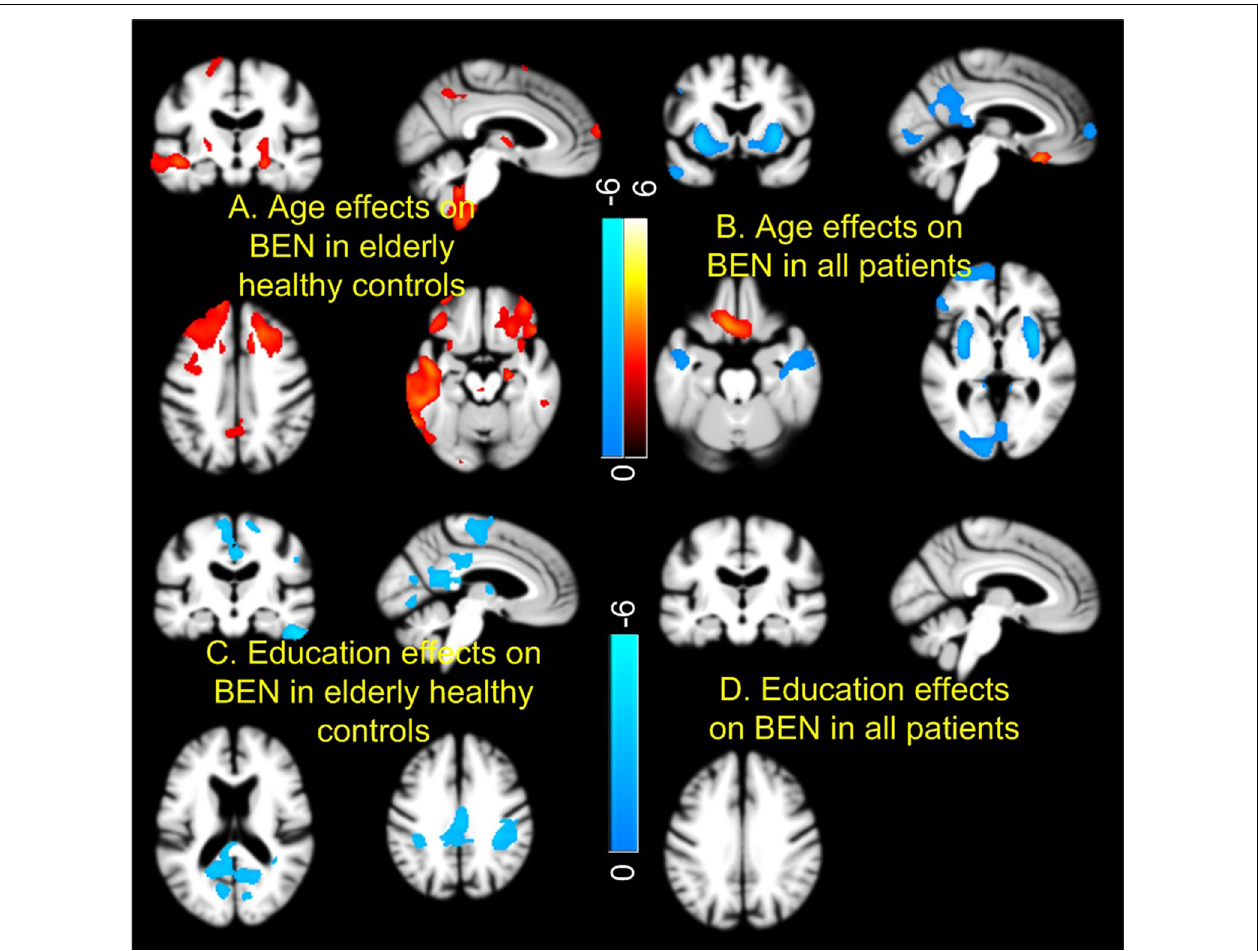
FIGURE 3 | Age and education effects of brain entropy (BEN). Controls and patients [mild cognitive impairment (MCI) and AD] showed opposite BEN vs. age relationship in most part of the brain (A,B) . Education years correlated with reduced BEN in default mode network in controls (C) , but not in patients (D) . Red and cool colors mean positive and negative correlations, respectively. Color bars indicate the display windows of the t -maps of the regression